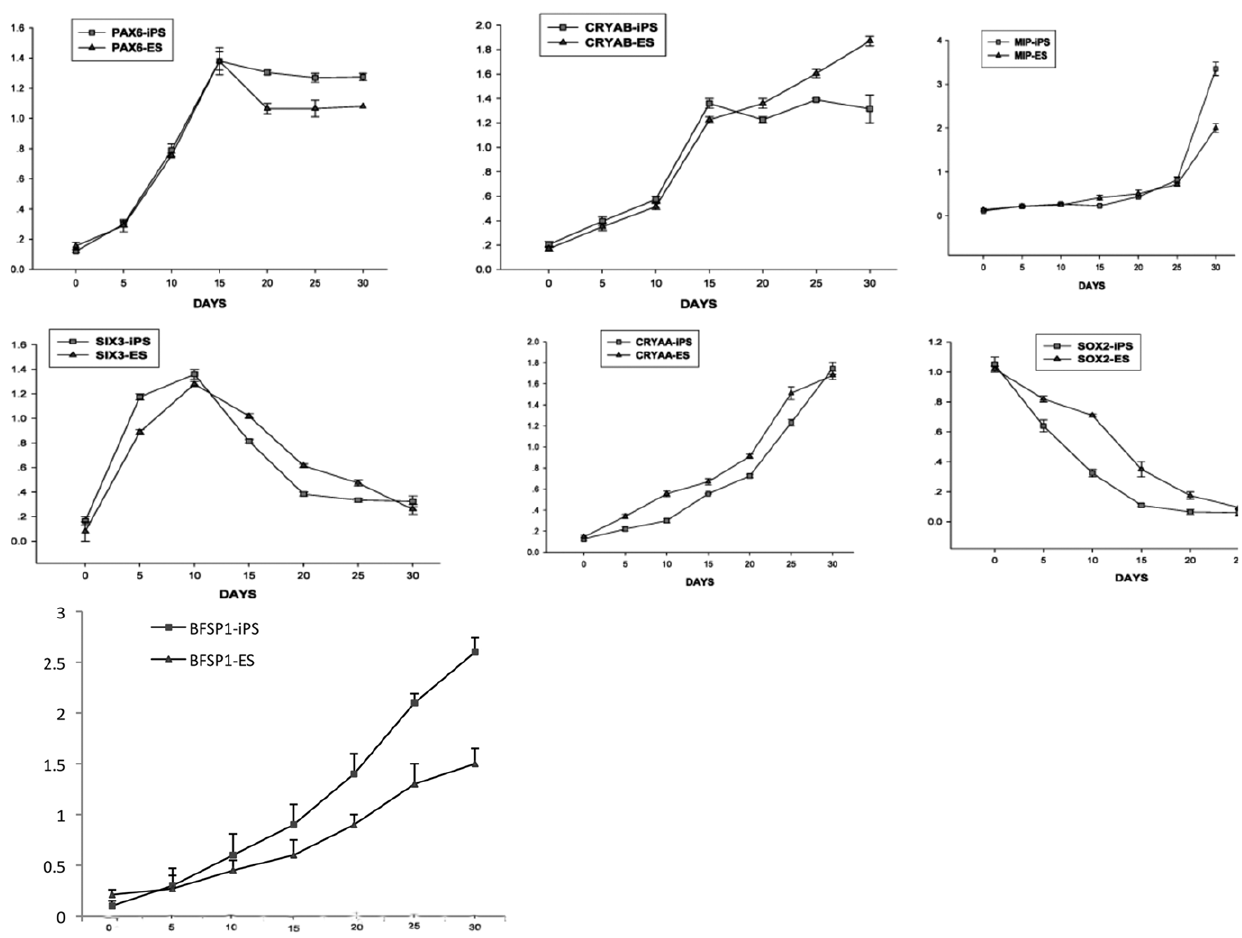
Figure 4. HLEC-iPS can be highly efficiently induced to express lens progenitor cell markers with defined chemical factors. Real-time RT-PCR analysis of 7 lens differentiation markers (PAX6, SOX2, SIX3, CRYAB, CRYAA, BFSP1, and MIP) in iPSCs and ESCs from d 0 to 30 following the initial plating. The results were calculated relative to the average Ct value of GAPDH. For details on the 3-step induction procedure, see Materials and Methods.